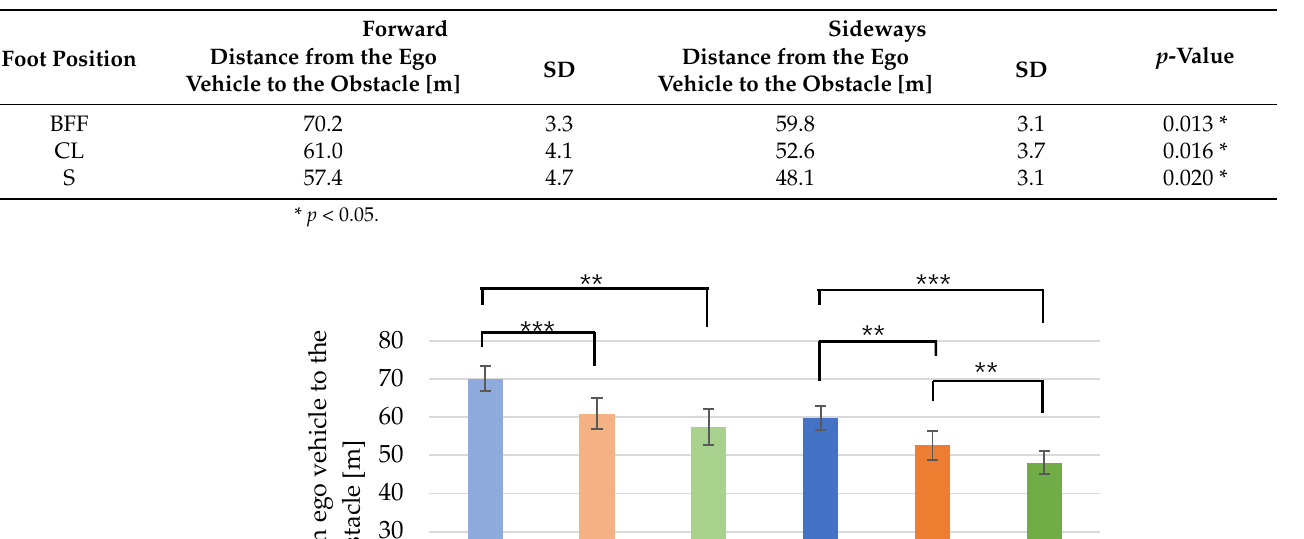
Table 7. Distance from the ego vehicle to the obstacle.